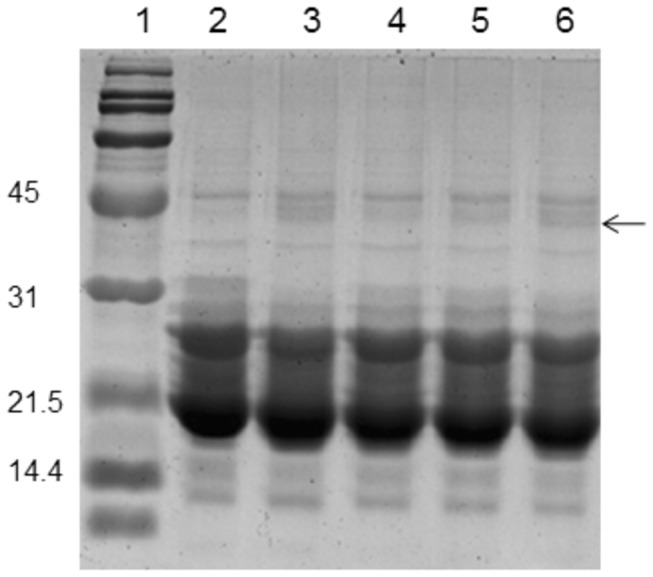
The effect of curcumin and nanocurcumin on protein crosslinking and the aggregation of the soluble fraction of the lens.Soluble protein was loaded onto a polyacrylamide gel. Lane 1: molecular mass markers; lane 2: control group; lane 3: diabetic group (D); lane 4: D + curcumin group; lane 5: D + nanocurcumin group and lane 6: D + blank particles group. Arrow: cross-linked proteins.